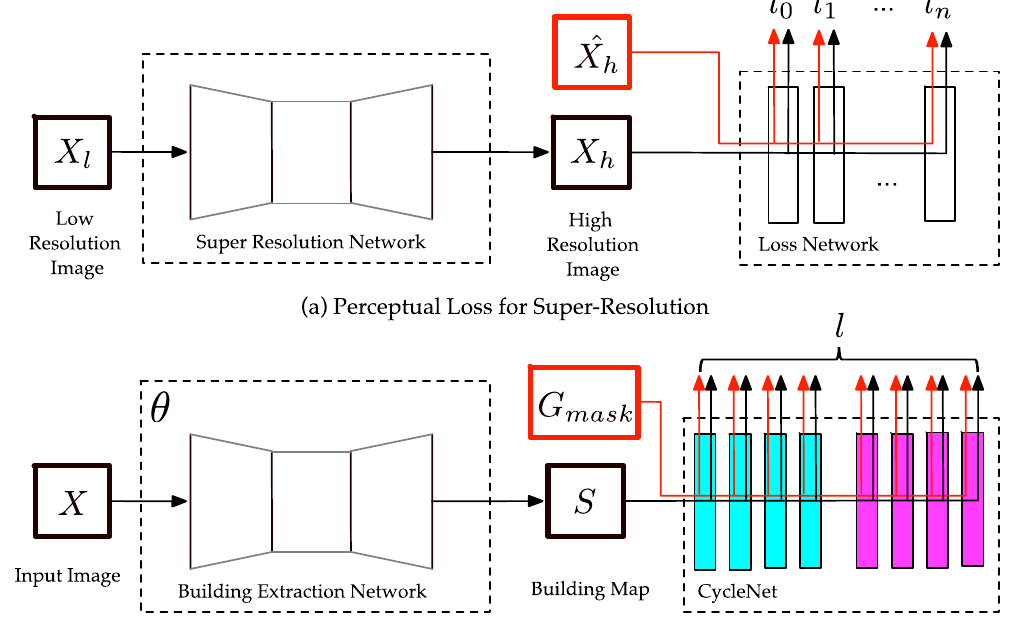
Figure 1. ( a ) and ( b ) are the overviews of the classical perceptual loss for the super-resolution task and the proposed boundary-aware perceptual (BP) loss for the building extraction task, respectively. In (a) ,𝑋 (cid:3039) and 𝑋 (cid:3035) are the low-resolution input image and its corresponding high-resolution prediction, respectively, and 𝑋 (cid:3035) (cid:3554) is the ground truth of 𝑋 (cid:3035) . 𝑙 (cid:3041) is the transfer function of the n th layer. In (b),